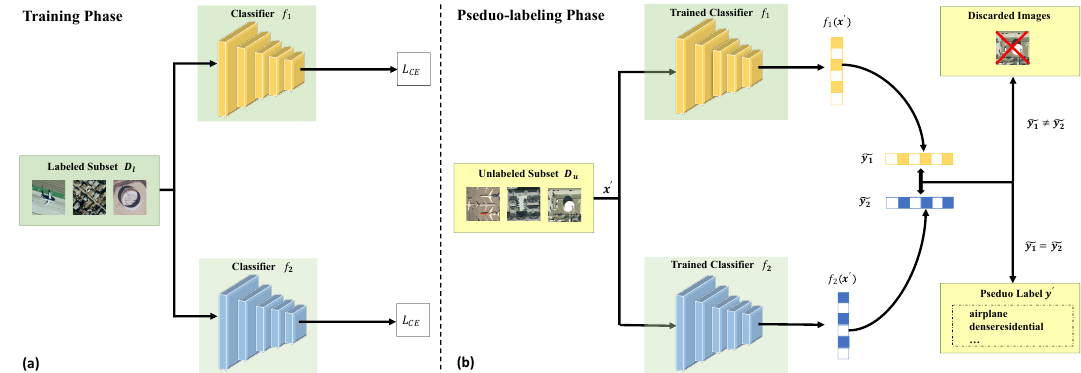
Figure 3. Illustration of the pseudo-labeling method, which includes two phases: training two classifiers and pseudo-labeling. ( a ) Two different classifiers f 1 and f 2 trained on the small manually labeled subset D l , respectively. They provide two views of the data. ( b ) The trained models can predict labels on a batch of unlabeled data. When the inferences are the same, the predicted labels will remain as pseudo-labels for the corresponding images, and the rest will be discarded. L CE donate CE loss. (cid:101) y 1 and (cid:48) indicates pseudo-labels of the batch of (cid:101) y 2 represent the predictions of two classifiers, respectively. (cid:126) y images (cid:126) x (cid:48)